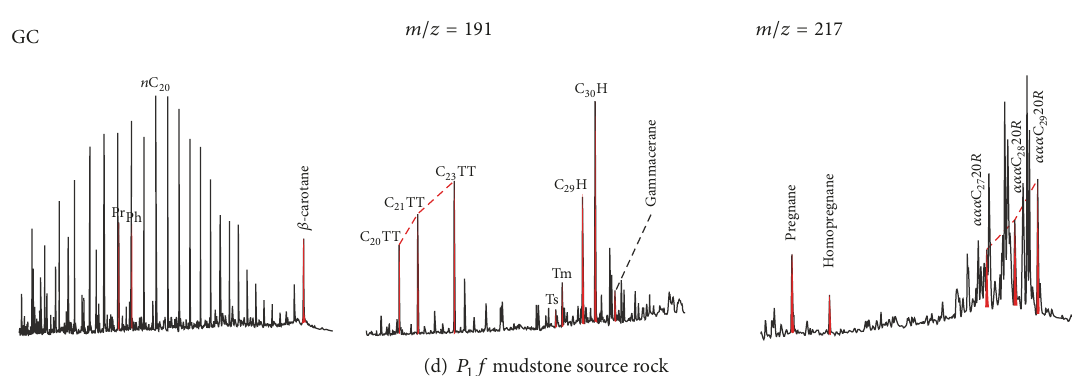
Figure 3: Gas chromatograms (GC) and GC-mass spectra (MS) of Triassic, Jurassic, and Permian mudstone source rocks in the central Junggar Basin. (a) Triassic mudstone source rock; (b) Jurassic mudstone source rock; (c) P 2 𝑤 -derived oil indicating P 2 𝑤 mudstone source rock; (d) P 1 𝑓 -derived oil indicating P 1 𝑓 mudstone source rock.